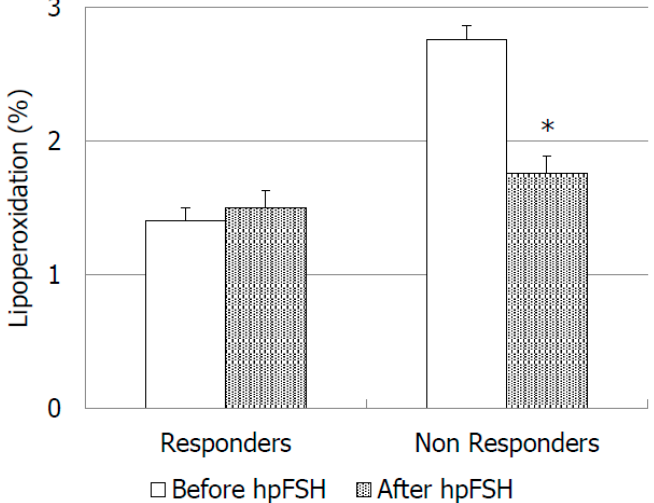
Figure 3. Percentage of spermatozoa with lipoperoxidation before and after treatment with high purified FSH (hpFSH) in infertile responder and non-responder patients. * p < 0.05.